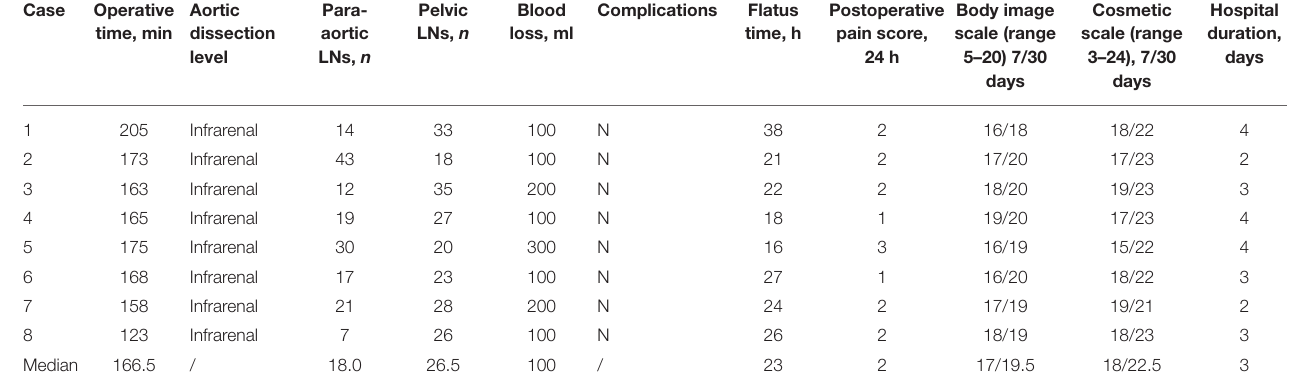
TABLE 2 | Surgical and postoperative